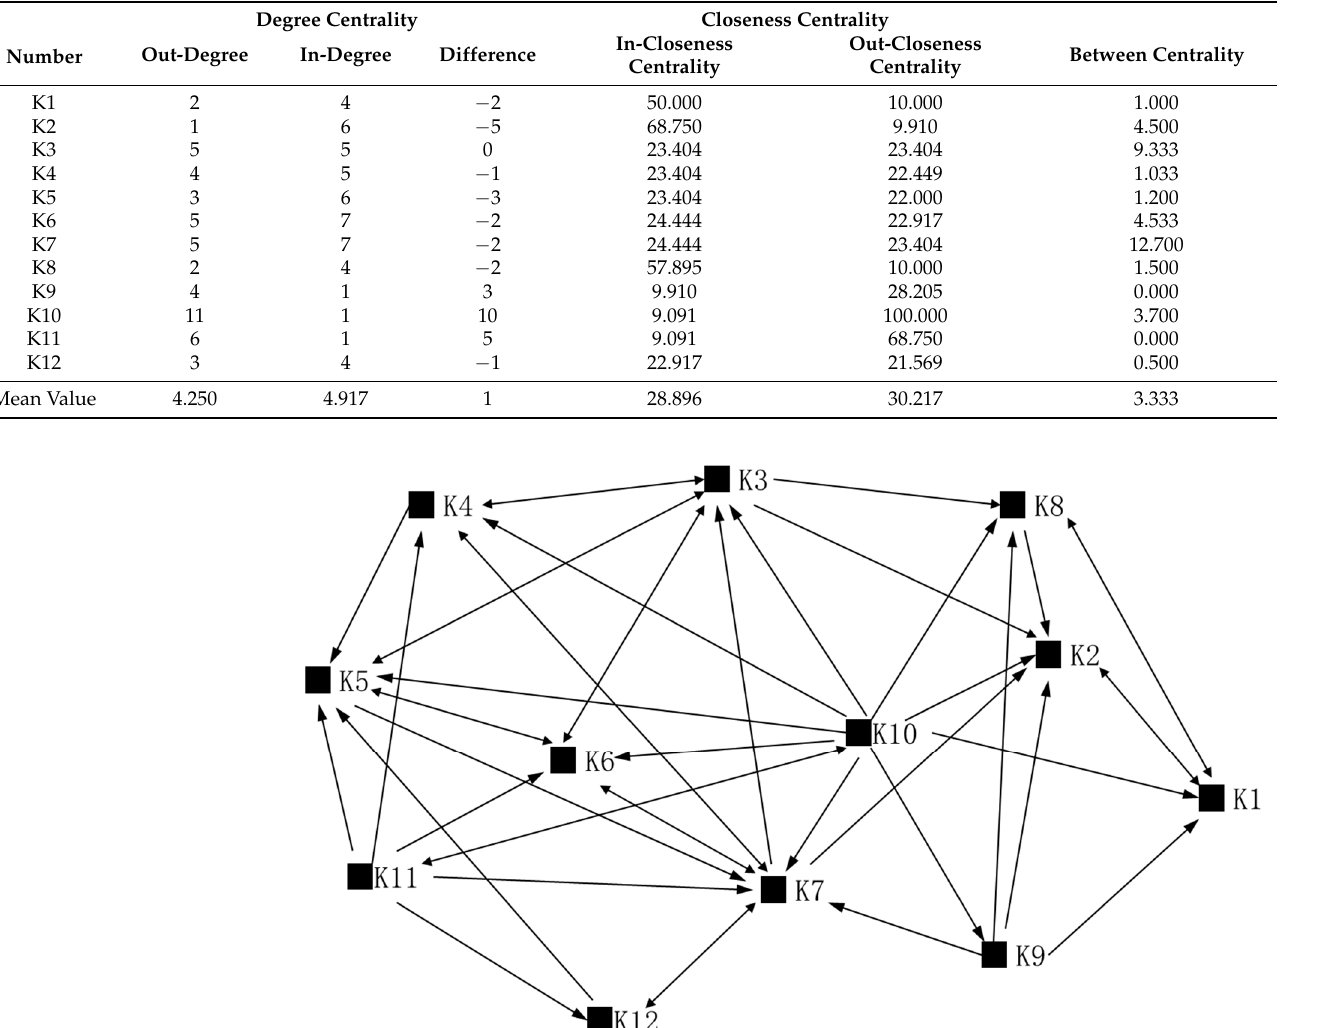
Figure 1. Network relationship of key hindering factors of BIM applications.